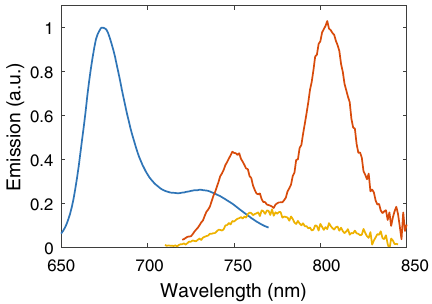
Figure 2. Steady-state fluorescence spectra of monomeric BChl c in ethanol (blue, excitation at 435 nm) and aggregated BChl c in chlorosomes from Cba. tepidum (yellow, excitation at 700 nm) and Cfl. aurantiacus (red, excitation at 710 nm) in a buffer at aerobic conditions. Both chlorosome spectra were multiplied by a factor of 40 for the sake of clarity.